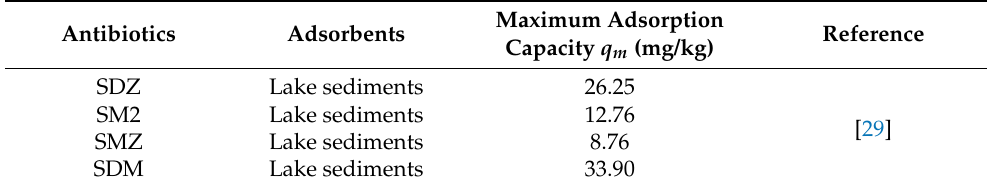
Table 5. Maximum adsorption capacity of lake sediments for four different sulfonamide antibiotics (mg/kg).